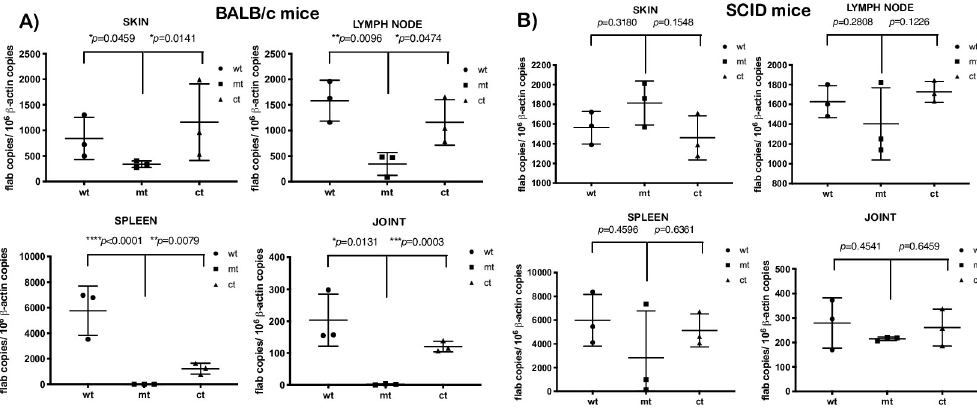
Fig 8. Quantitative real-time PCR analysis of spirochetal burden in BALB/c or SCID mice infected with bpiP mutant. Groups ( n = 3) of 4-week old immunocompetent BALB/c or immunodeficient SCID mice were intradermally infected via needle inoculation with wt, mt and ct strains with 10 5 spirochetes per mouse and were analyzed. Total genomic DNA was isolated from tissue (skin, lymph node, spleen and one joint) using the High Pure PCR template preparation kit and was then subjected to quantitative real-time PCR. Numbers of borrelial flaB copies were normalized against total mouse β -actin. Data analyzed using a one-way analysis of variance test with Tukey’s multiple-comparison test. Statistical significance was accepted when p values were less than 0.05. Tissues samples analyzed were collected at day 28 from (A) BALB/c (B) SCID mice.